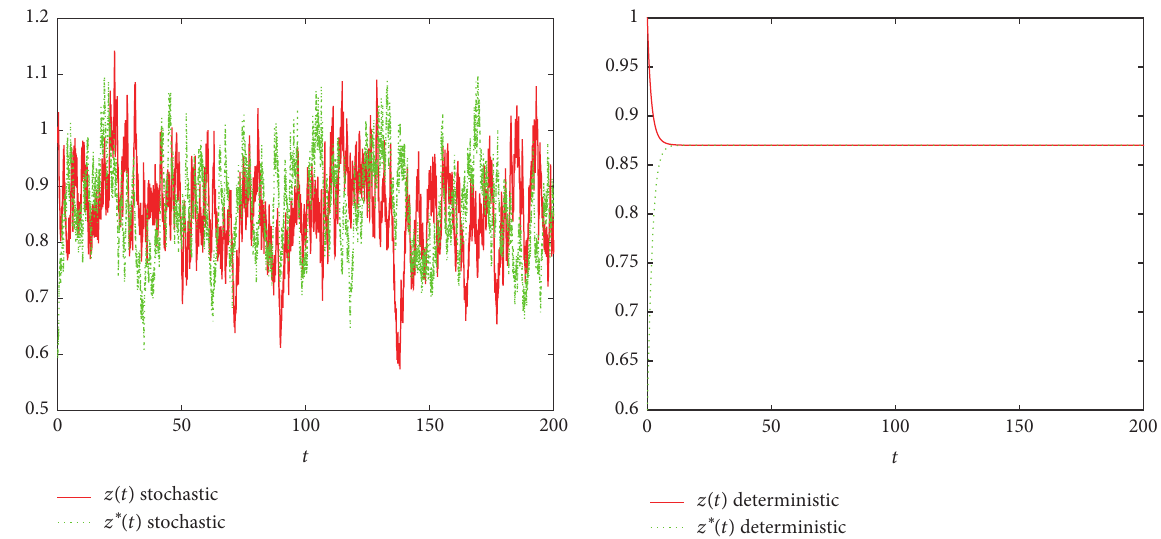
Figure 8: The path curve of 𝑧(𝑡) and 𝑧 ∗ (𝑡). Red: solution of model (62) for 𝛾 1 (𝜃) = (1.5,1.3, 1) . Green: solution of model (62) for 𝛾 ∗ 1 = (0.7, 0.8, 0.6)